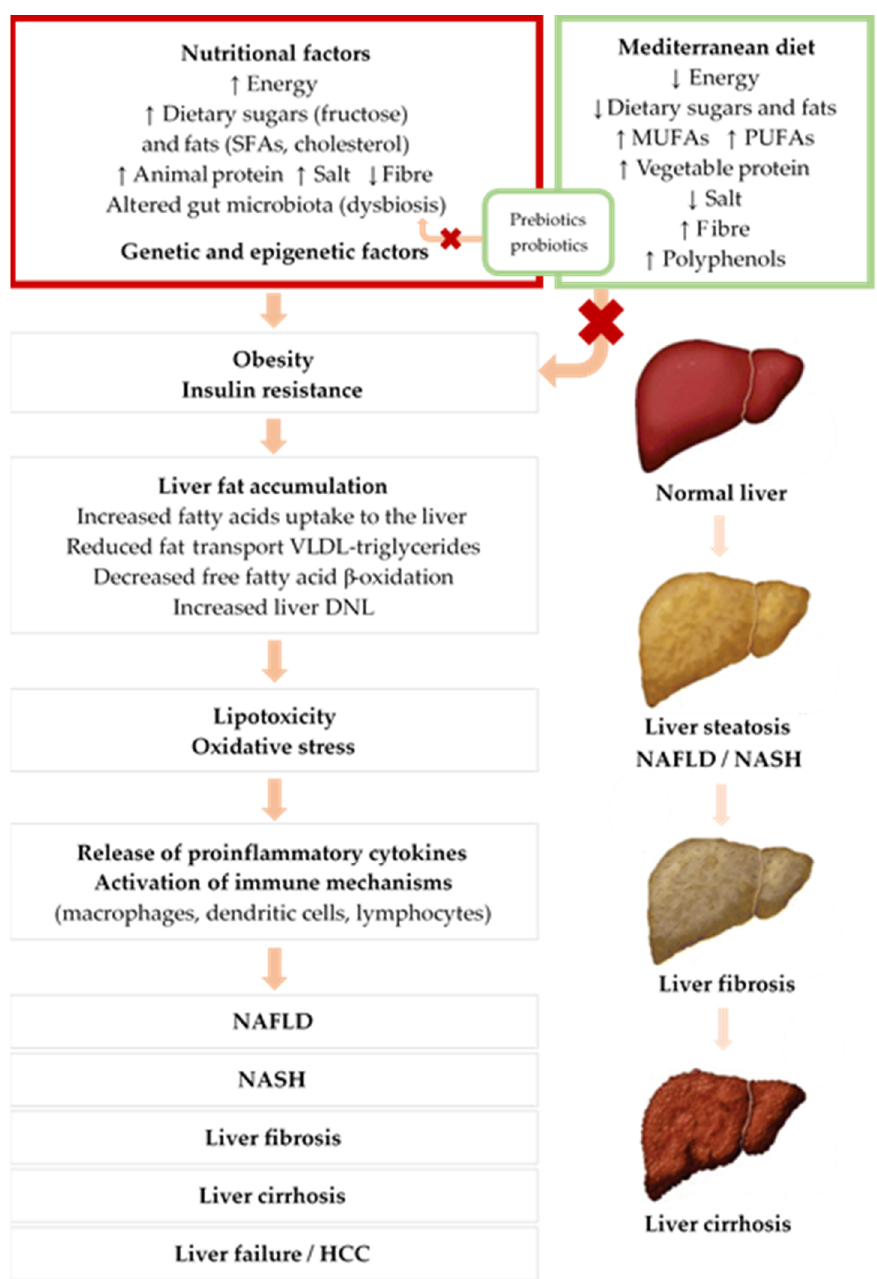
Figure 1. Mechanisms of NAFLD development and the influence of nutritional factors. Upwards pointing arrows ( ↑ ) indicate increased intake, downwards pointing arrows ( ↓ ) indicate decreased intake. Abbreviations: SFAs: saturated fatty acid; MUFAs: monounsaturated fatty acids; PUFAs: polyunsaturated fatty acids; VLDL: very low-density lipoprotein; DNL: de novo lipogenesis; NAFLD: non-alcoholic fatty liver disease; NASH: non-alcoholic steatohepatitis; HCC: hepatocellular carcinoma.